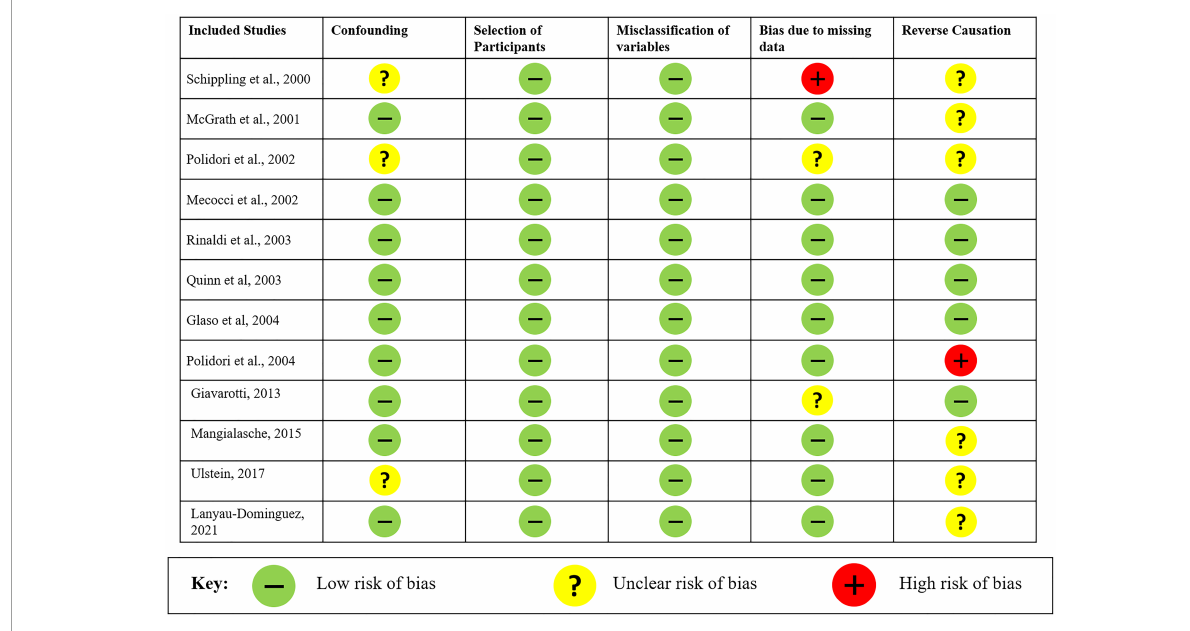
FIGURE5 Risk of bias analysis of studies evaluated using Cochrane’s Risk Of Bias tool in Non-randomized Studies–of Exposures